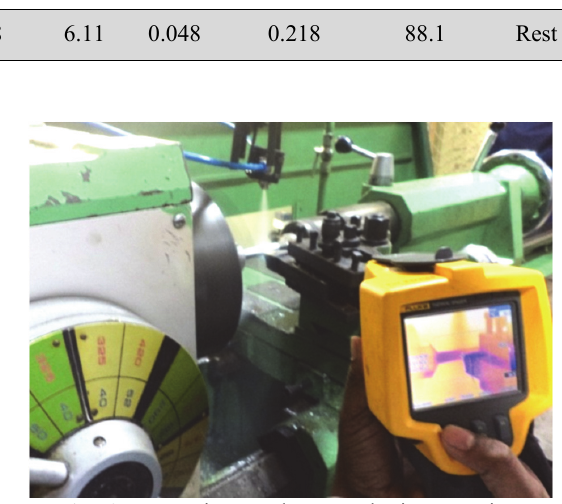
Fig. 1. Optical micrograph of the AMC sample Fig. 2. Experimental setup during turning